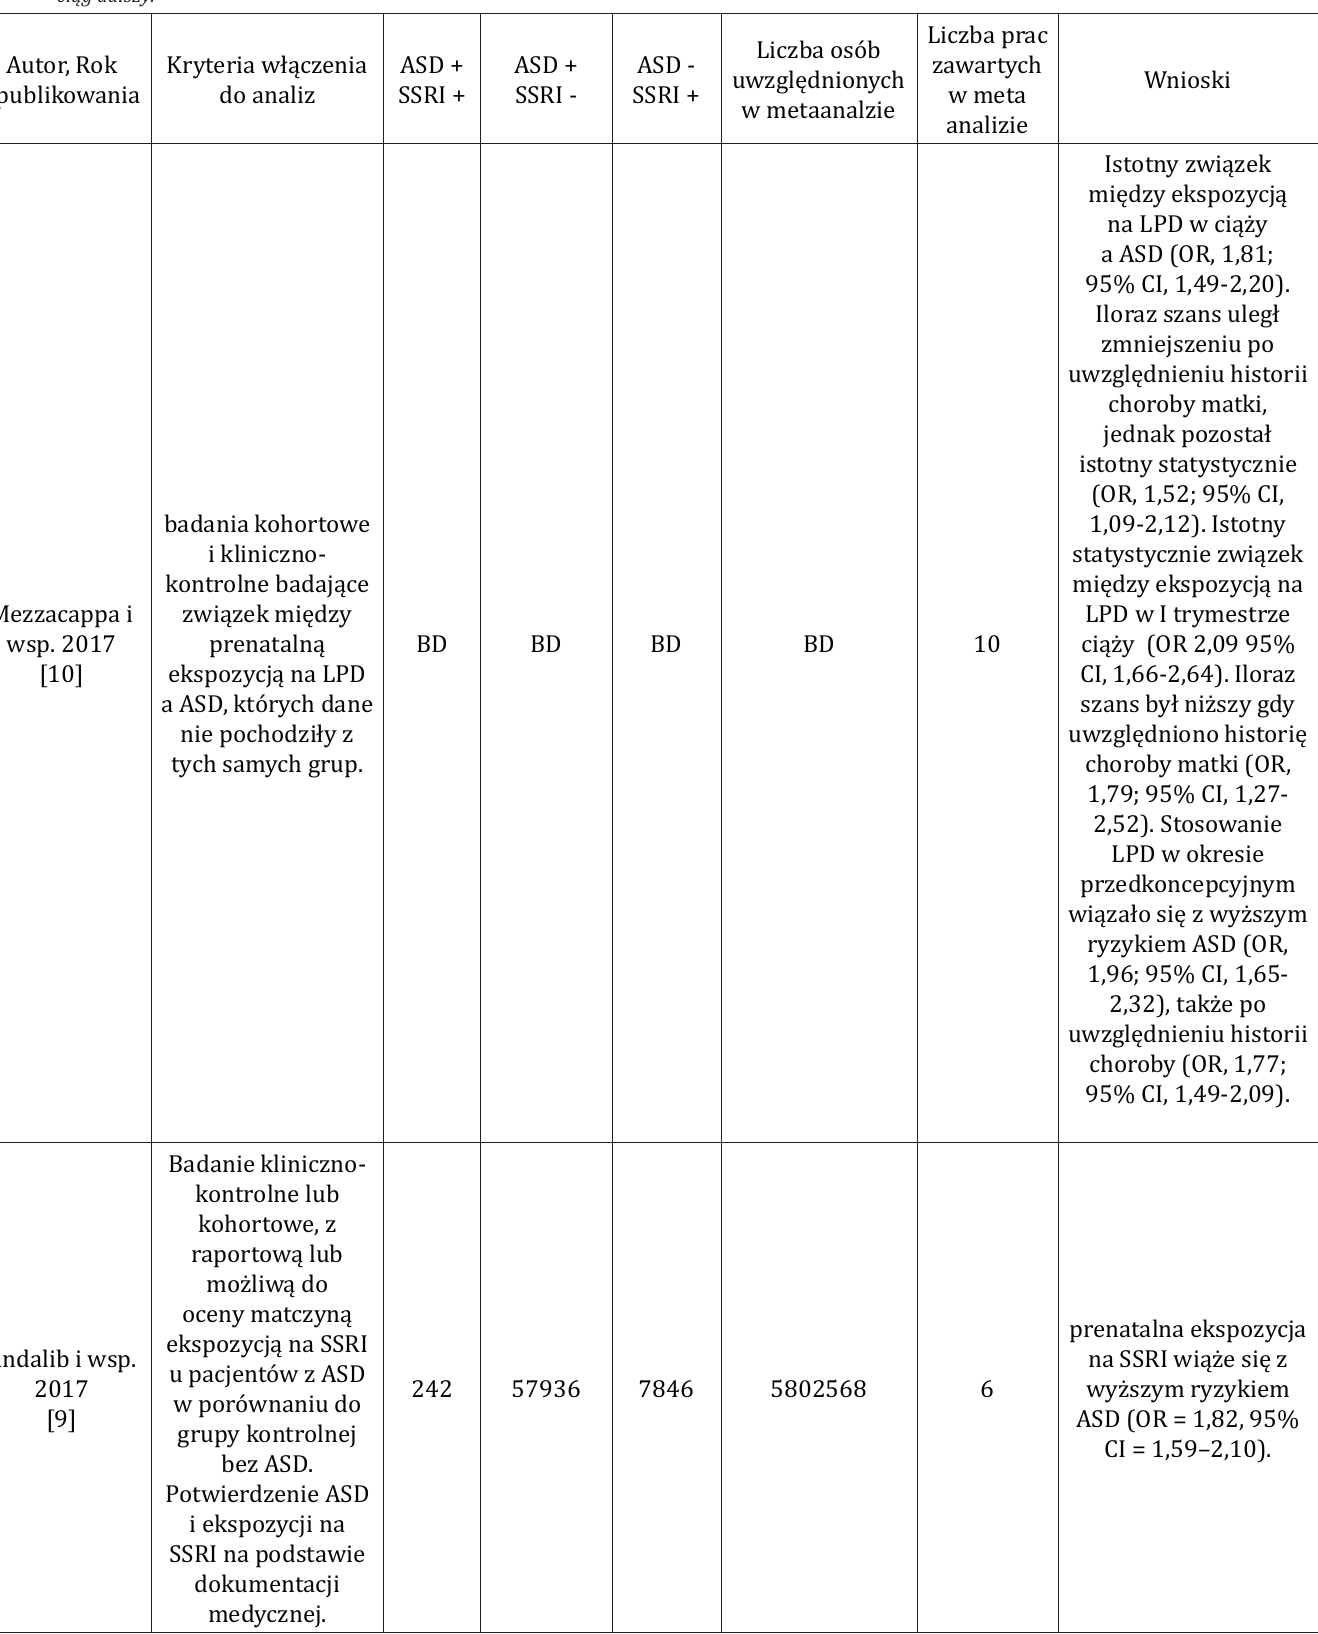
Tab. 1. Porównanie meta-analiz dotyczących związku między prenatalnym narażeniem na SSRI a zaburzeniami ze spektrum autyzmu - ciąg dalszy.